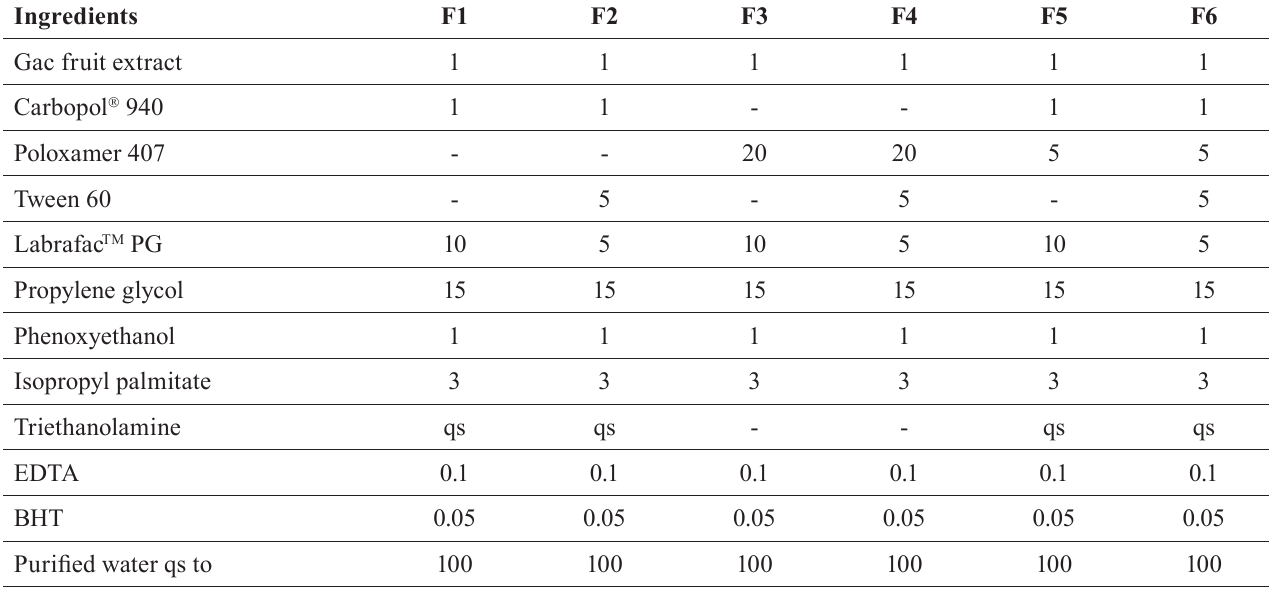
TABLE I - C omposition of hydrogels of the Gac fruit extract (% w/w) Ingredients Gac fruit extract